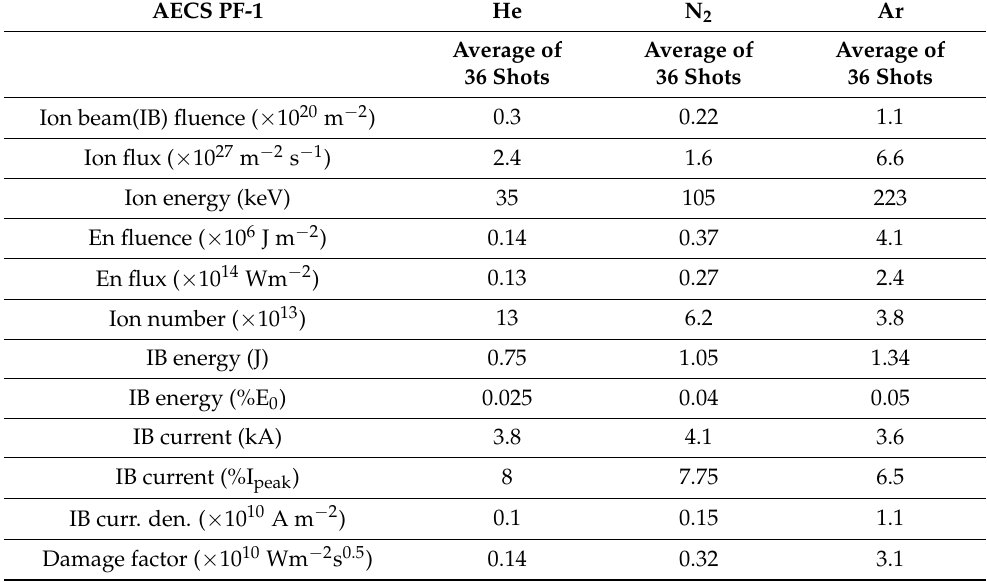
Table 3. Average ion beam characteristics of the AECS PF-1 device at 0.6 Torr for N 2 , Ar, and He.